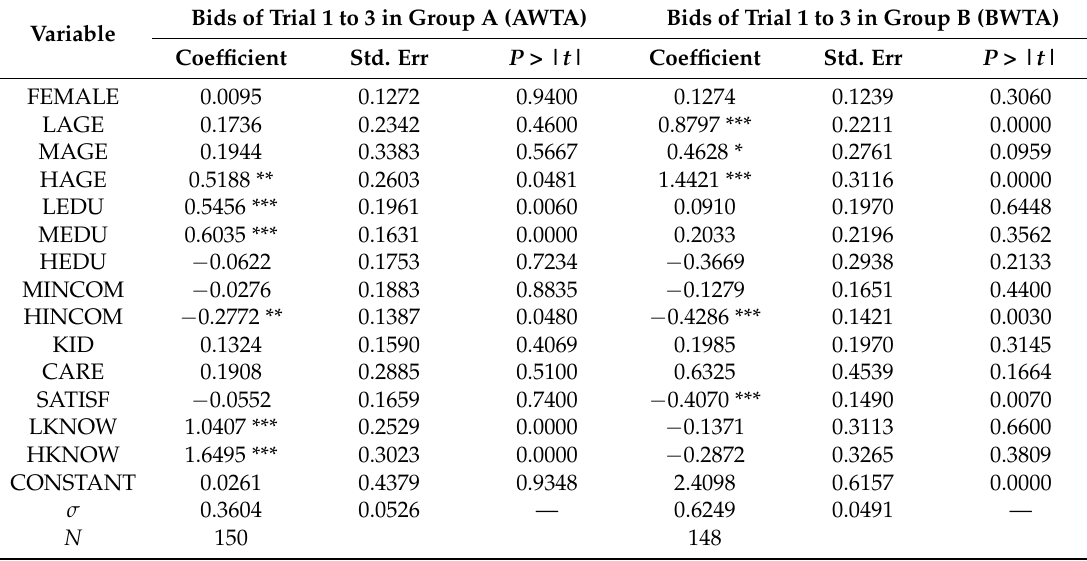
Table 7. Parameter estimation results of no-information